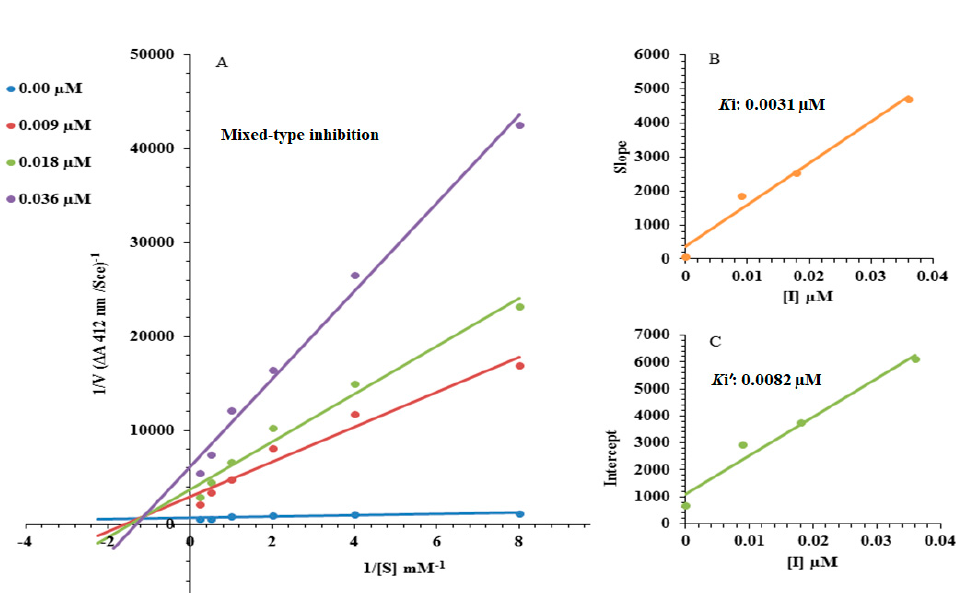
Figure 2. Lineweaver–Burk plots for the inhibition of AChE from human erythrocytes in the presence of compound 3b . ( A ) The concentrations of 3b were 0.00 µM, 0.009 µM, 0.018 µM, and 0.036 µM, and the substrate (urea) concentrations were 4 mM, 2 mM, 1 mM, 0.5 mM, 0.25 mM, and 0.125 mM. ( B ) The insets represent the plots of the slope ( C ) regarding the vertical intercepts versus the inhibitor concentrations, which were used to determine the inhibition constants.